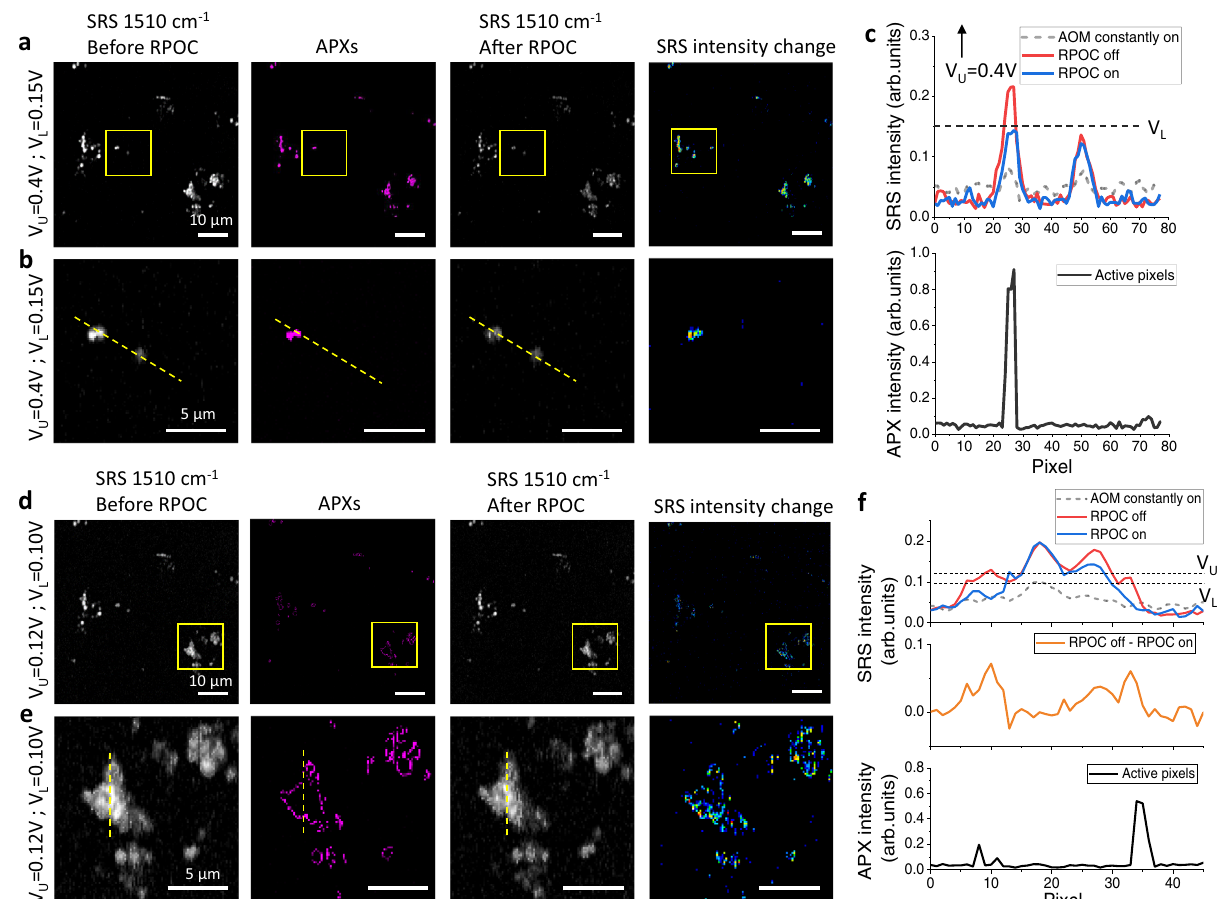
Fig. 5 | Precision control of chemical changes by RPOC using different optical intensity ranges. a A stimulated Raman scattering (SRS) image of CMTE at 1510cm − 1 before RPOC (left), APXs selected by an upper threshold (V U ) of 0.4V andlowerthreshold(V L )of0.15V(middleleft),anSRSimageat1510cm − 1 afterthe RPOC of the CMTE (middle right), and the SRS intensity difference before and after RPOC (right). b Magni fi ed images from the highlighted regions in panel a . c SRS and APXs intensity pro fi les along the dotted lines in panel b . The dashed